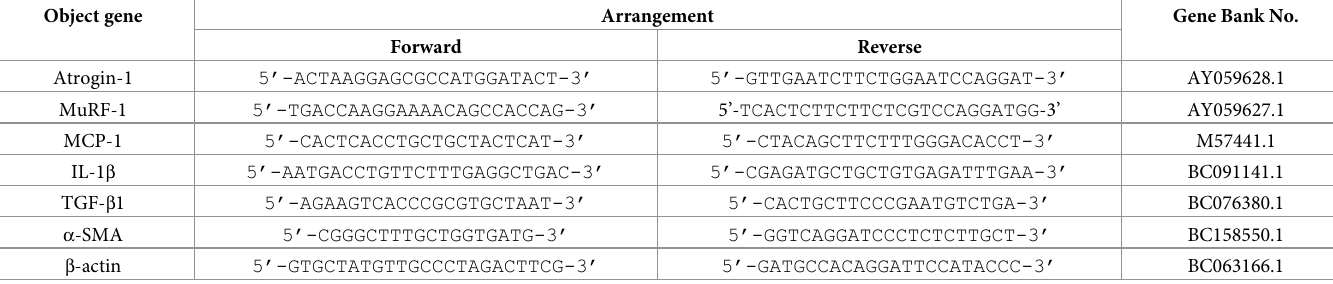
Table 1. Arrangement of synthetic gene-specific